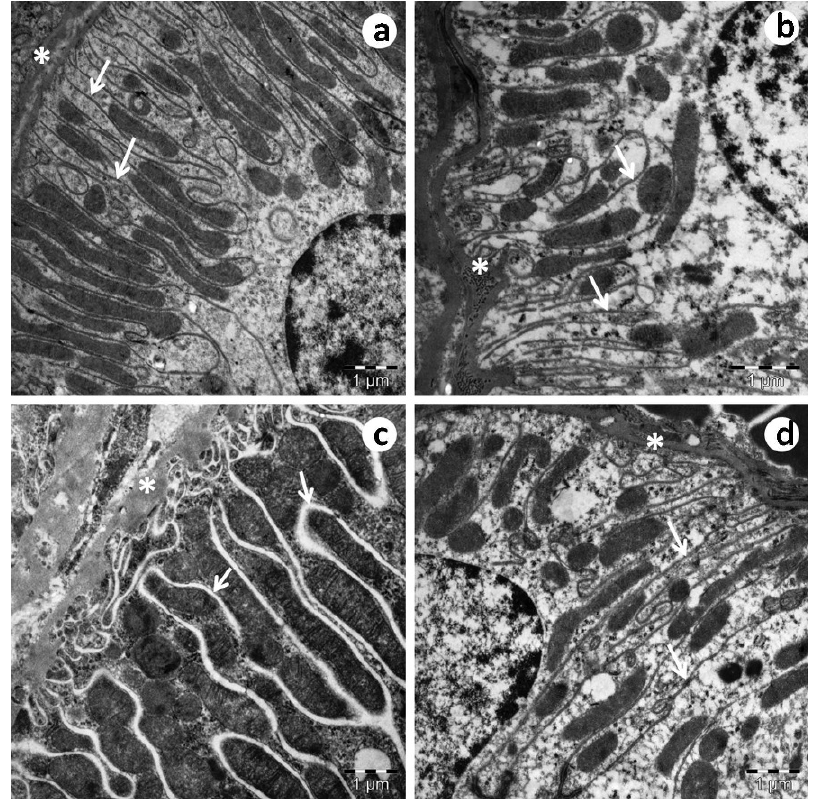
Figure 4 - An electron micrograph of a convoluted distal tubule. In the SED-SHR (c), there is an increase in the space between the interdigitations (arrow), and the basal membrane (*) of the tubules exhibits a thickened appearance compared to the EX-SHR (d) and the SED-WKY (a) and EX-WKY (b) control groups. Abbreviations: EX, exercised; SHR, spontaneously hypertensive rats; SED, sedentary; WKY,